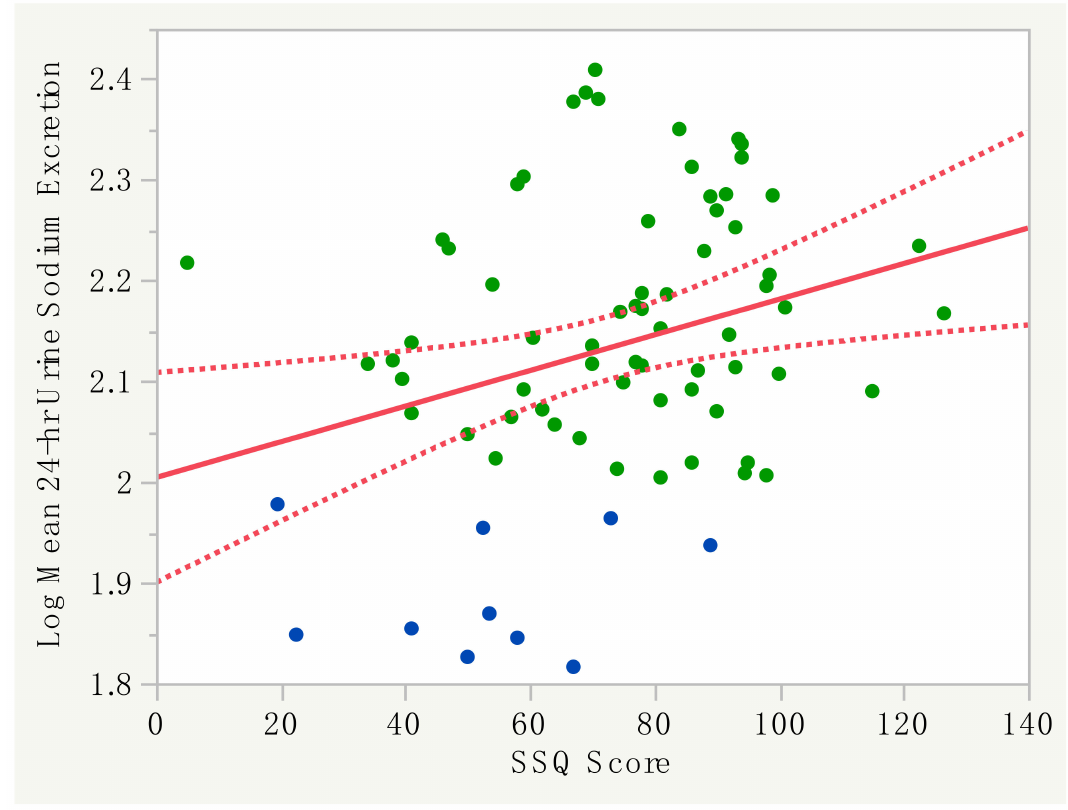
Figure 2. Graph showing the correlation between the SSQ score and log mean 24-h urine sodium showing the line of fit (solid line) ( r = 0.29; p = 0.01) and confidence curves for the fitted line (dotted line and shaded area). Green dots represent participants with 24-h urine Na ≥ 100 mmol / day and blue dots with Na < 100 mmol /